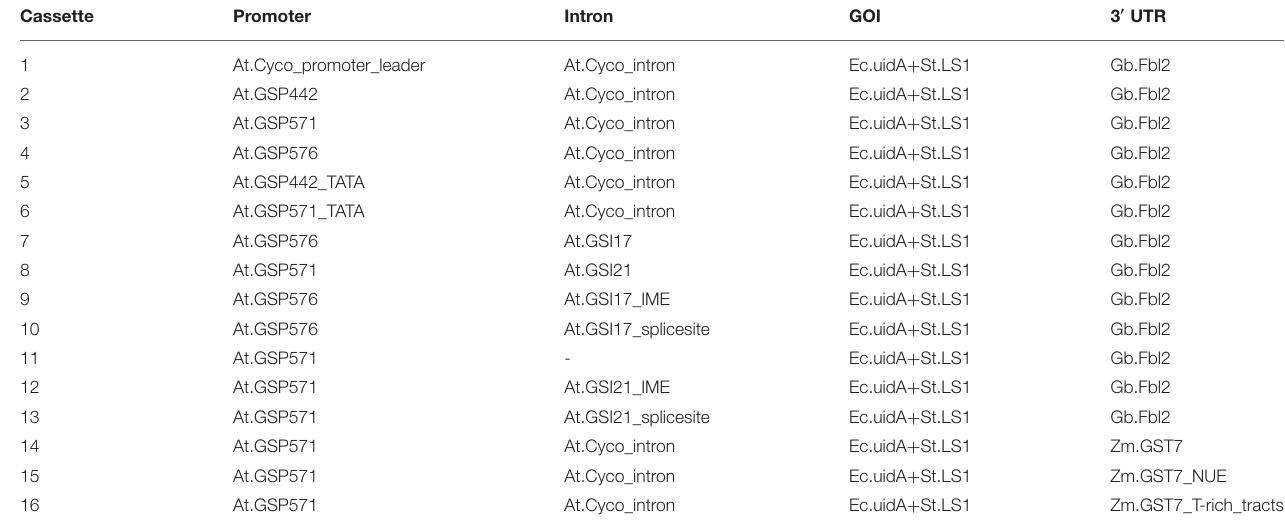
TABLE 1 | A list of expression